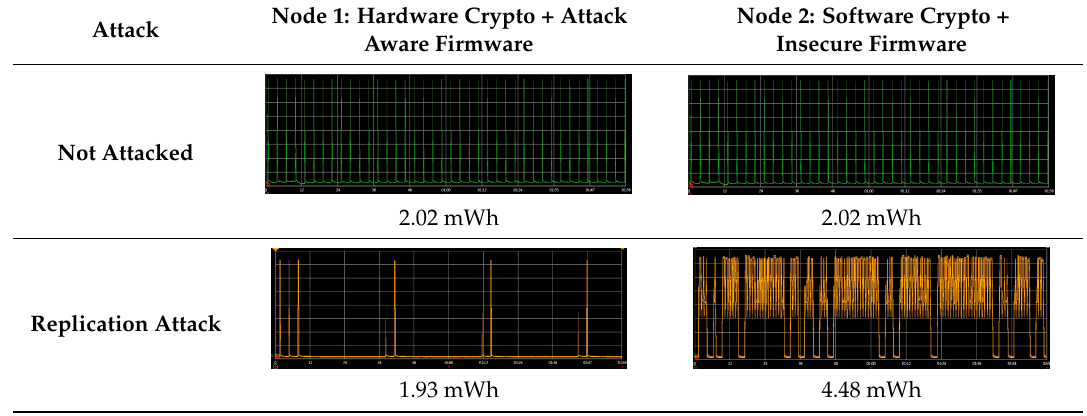
Table 8. Real/Simulation Consumption Results for